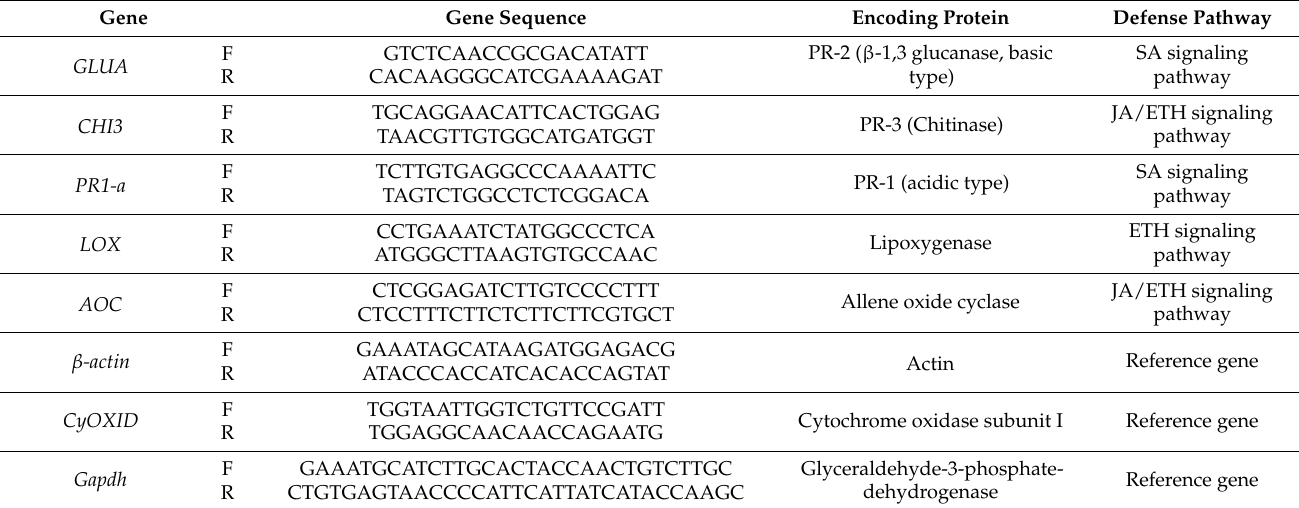
Table 5. Primers used in RT-qPCR of the 5 genes ( GLUA, CHI3, PR1-a, LOX, and AOC ) associated with response mechanisms to pathogens and the 3 housekeeping genes ( β -actin, CyOXID, and Gapdh ).